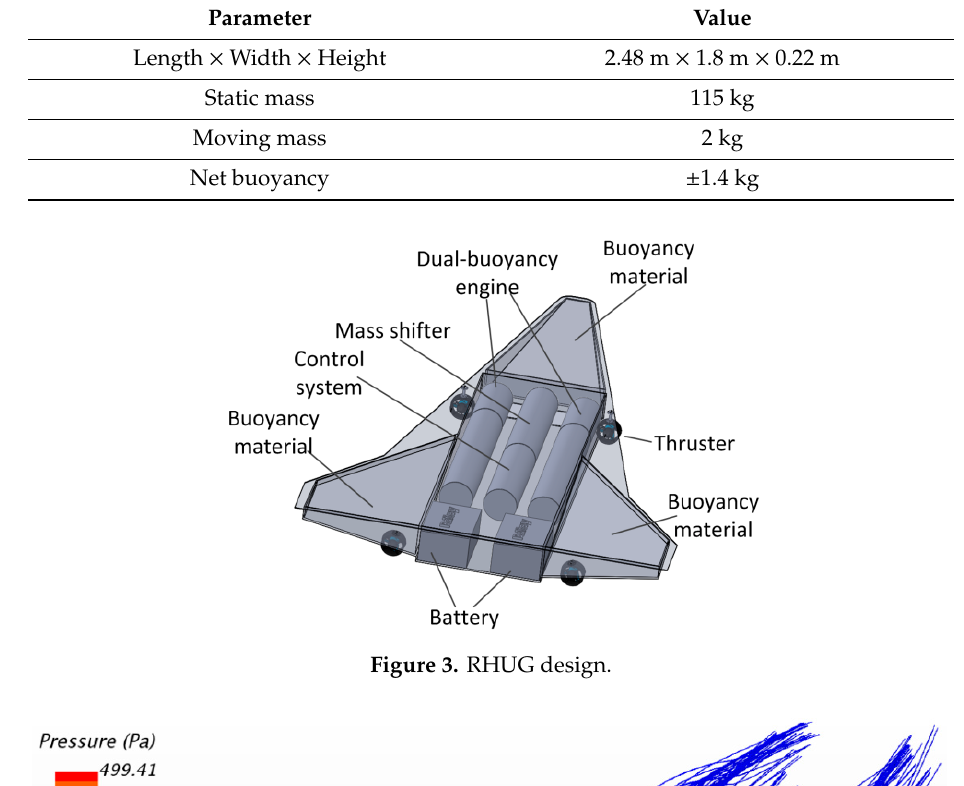
Table 1. Specification of RHUG.